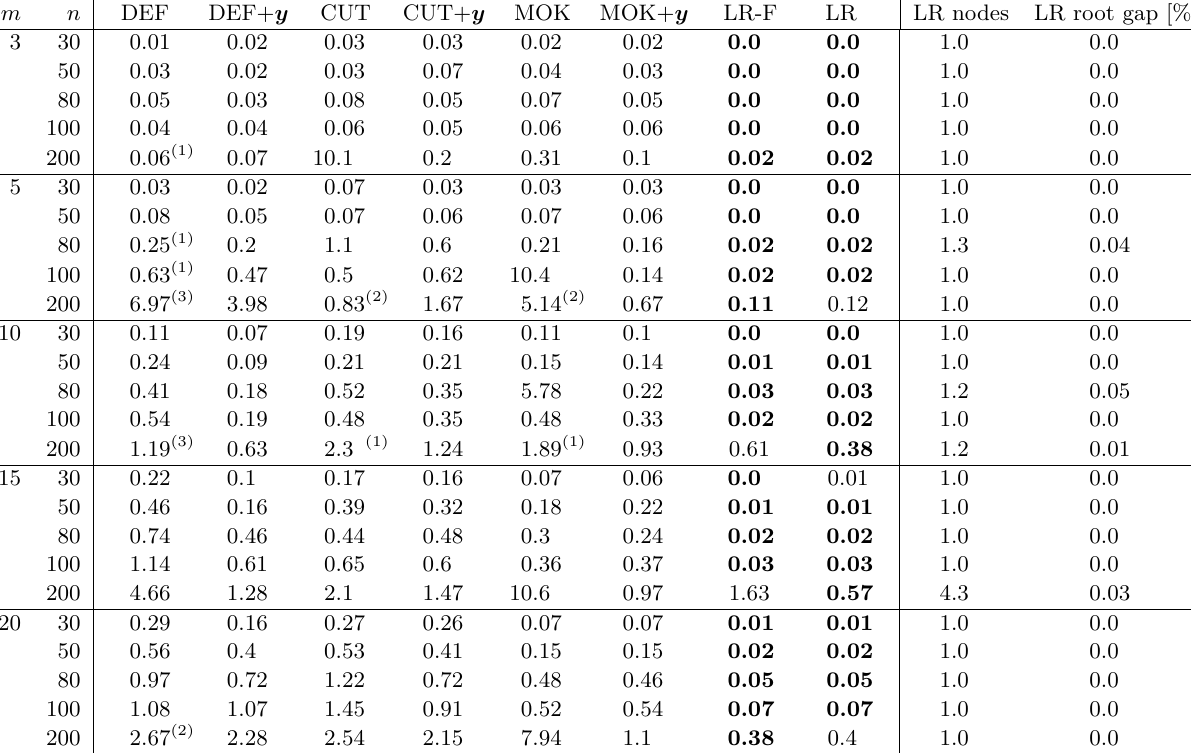
Table 3 The average computing time [s] for solving ten correlated machines instances of size m × n . Within parentheses are the numbers of instances exceeding the time limit of 120 s; these instances do not contribute to the average computing times. The average number of branch–and–bound nodes and the average gap ( z − z ) in the root node is presented for z